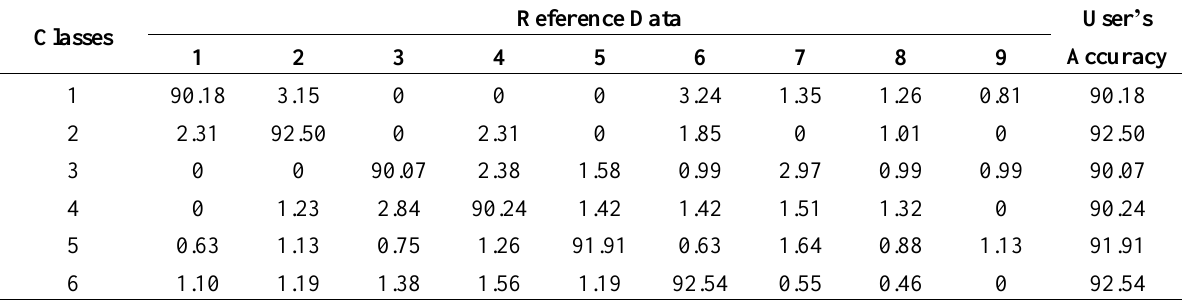
Table 4. The classification error matrix for data set Pavia University (in